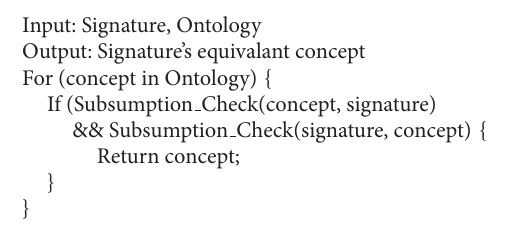
Algorithm 1: Algorithm of module extraction (signature mapping